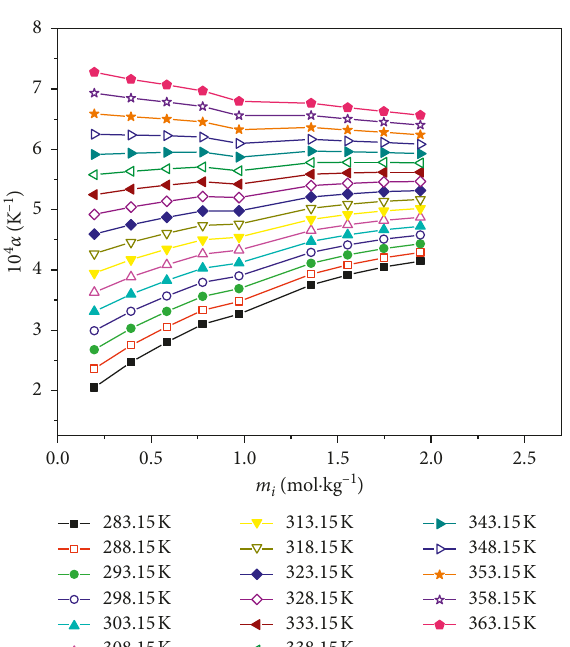
Table 5: The pitzer single-salt parameters of NaAsO